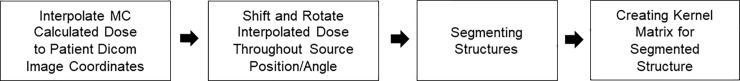
Creation of dose kernel matrix.Procedure to create dose kernel matrix from MC-simulated dose distribution for inverse planning.